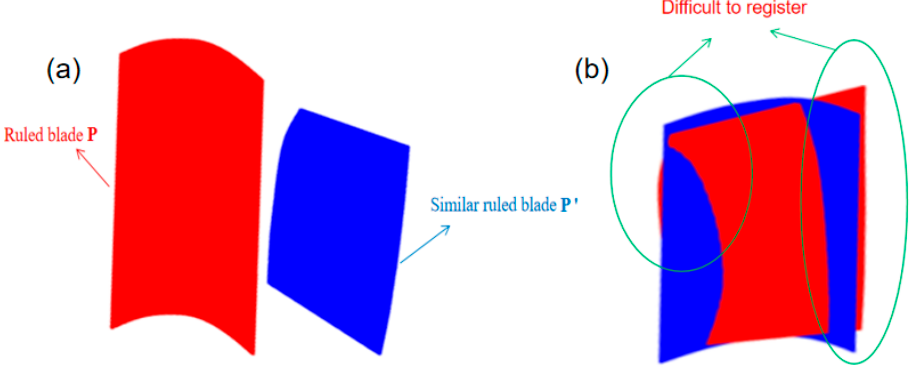
Figure 5. Overall point cloud registration of similar surfaces: ( a ) Point cloud initial state, ( b ) point cloud overall registration effect .